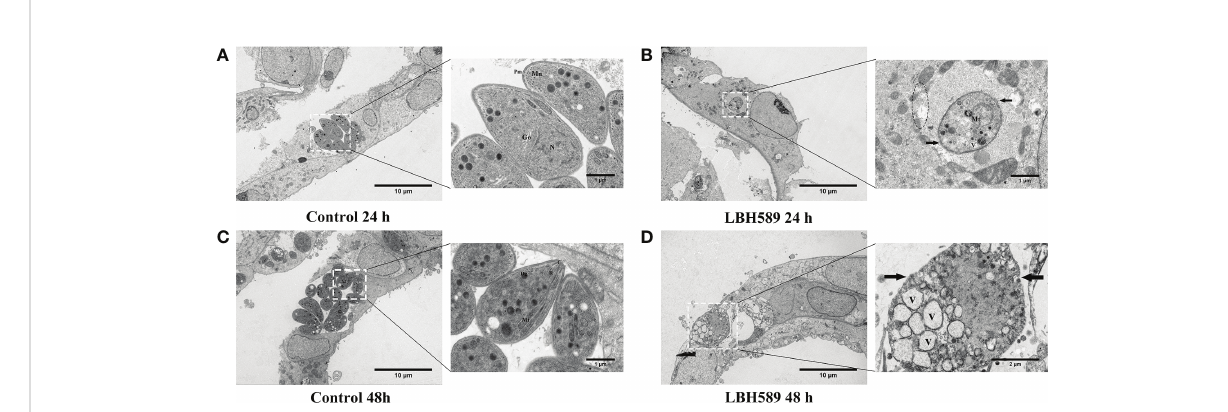
FIGURE 4 Ultrastructural alterations of tachyzoites internalized in RPE cells after LBH589 treatment at 750 nM by TEM. (A, C) Untreated parasites in RPE cells (set as the control) present normal morphology at both 24 and 48 h, the inset shows the typical ultrastructure, including the conoid (C), microneme (Mn), rhoptry (R), plasmalemma (Pm), dense granule (Dg), mitochondrion (Mt), golgi apparatus (G), and nucleus (N). (B) Exposure to LBH589 for 24 h induced unusual microstructural changes, such as mitochondrial swelling, vacuole (V), disruption of plasmalemma (black arrow) and vacuolar membranes (black circle). (D) After 48 h of incubation with LBH589, the parasites lost their biological features and the cytoplasmic structure was almost completely destroyed. Scale bars: A, B, C and D = 10 m m; A, B and C insets = 1 m m, D inset = 2 m m. The experiments were performed in triplicate, in three independent experiments.